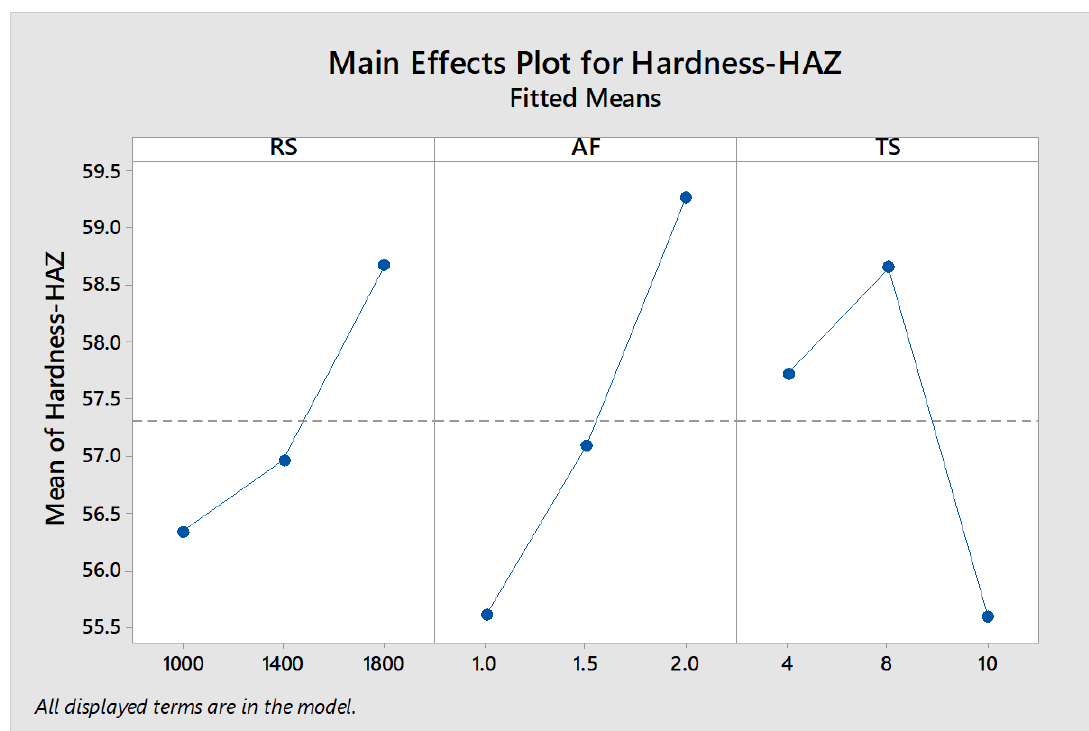
Figure 23. Main e ff ects plot—hardness in HAZ. Figure 23. Main effects plot — hardness in HAZ. Figure 23. Main effects plot — hardness in HAZ.